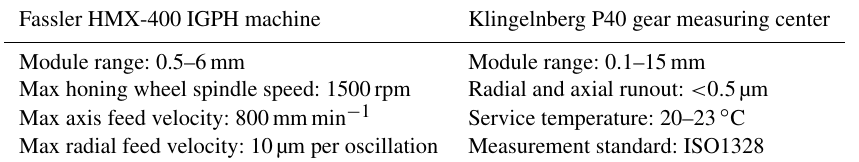
Figure 2. HMX-400 IGPH machine and Klingelnberg P40 gear measuring center. Table 1. The main technological parameters of the experiment